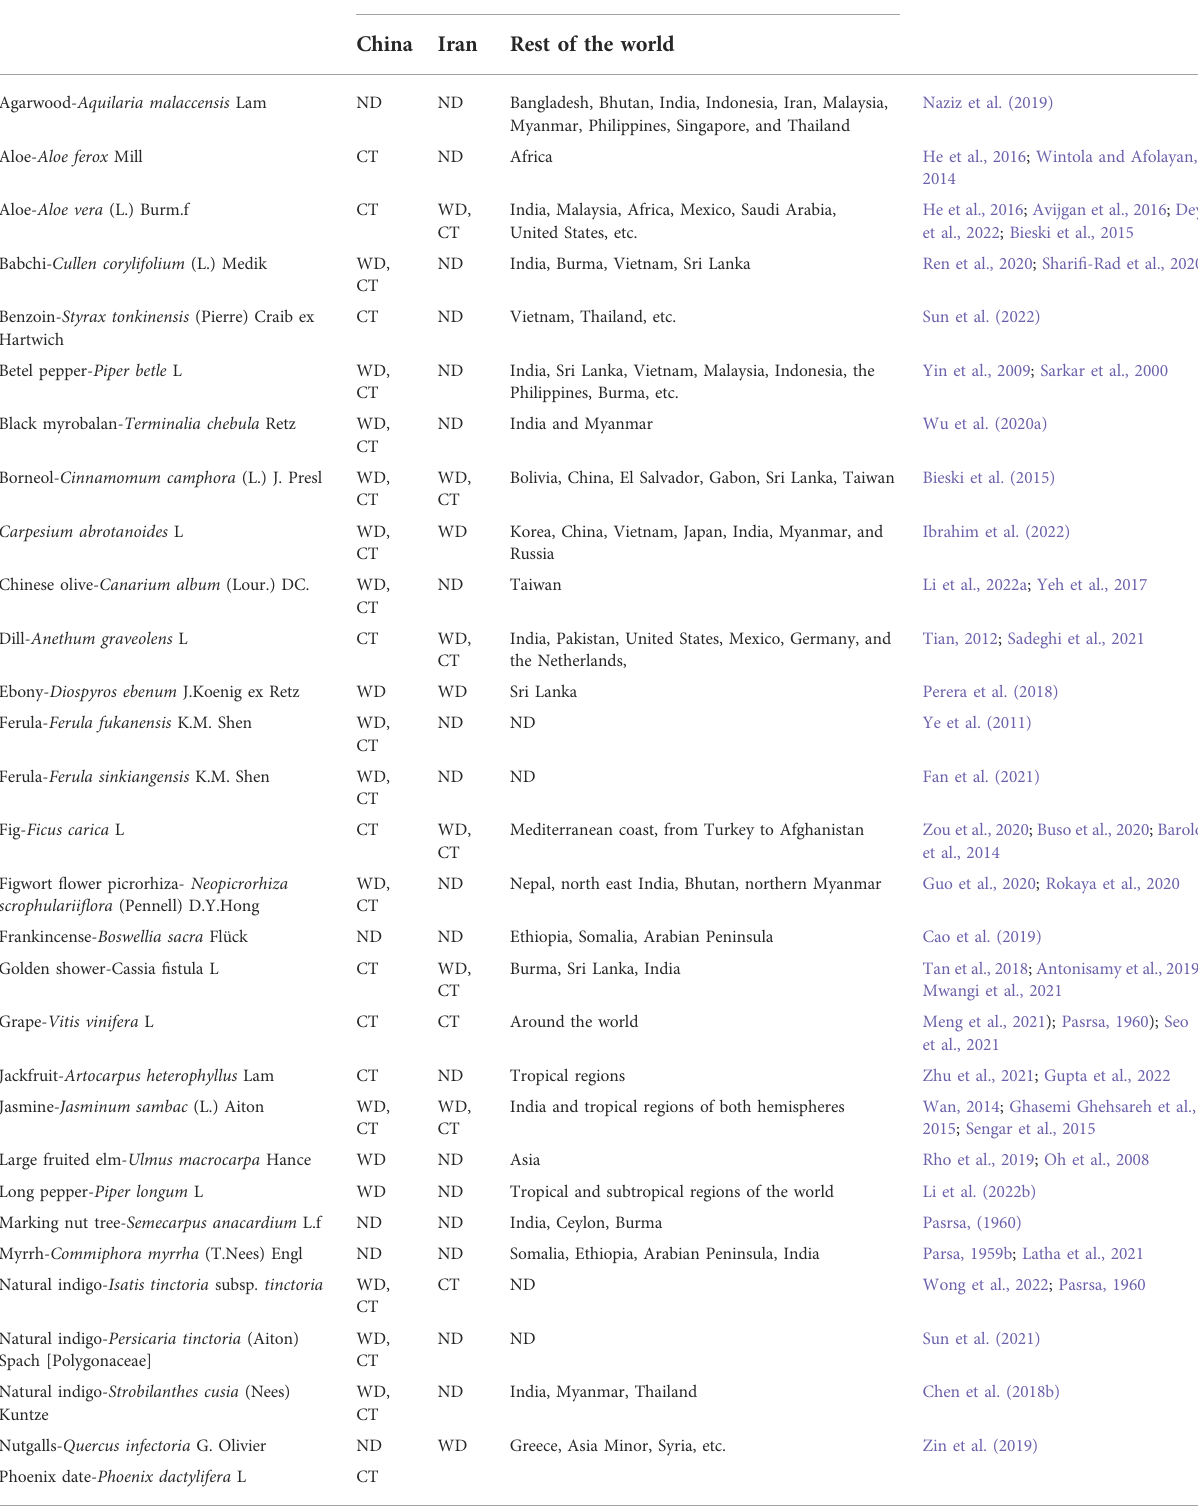
TABLE 1 Medicinal plants exported from Persia to old China as recorded in the Compendium of Materia Medica. The current distribution of these plants is